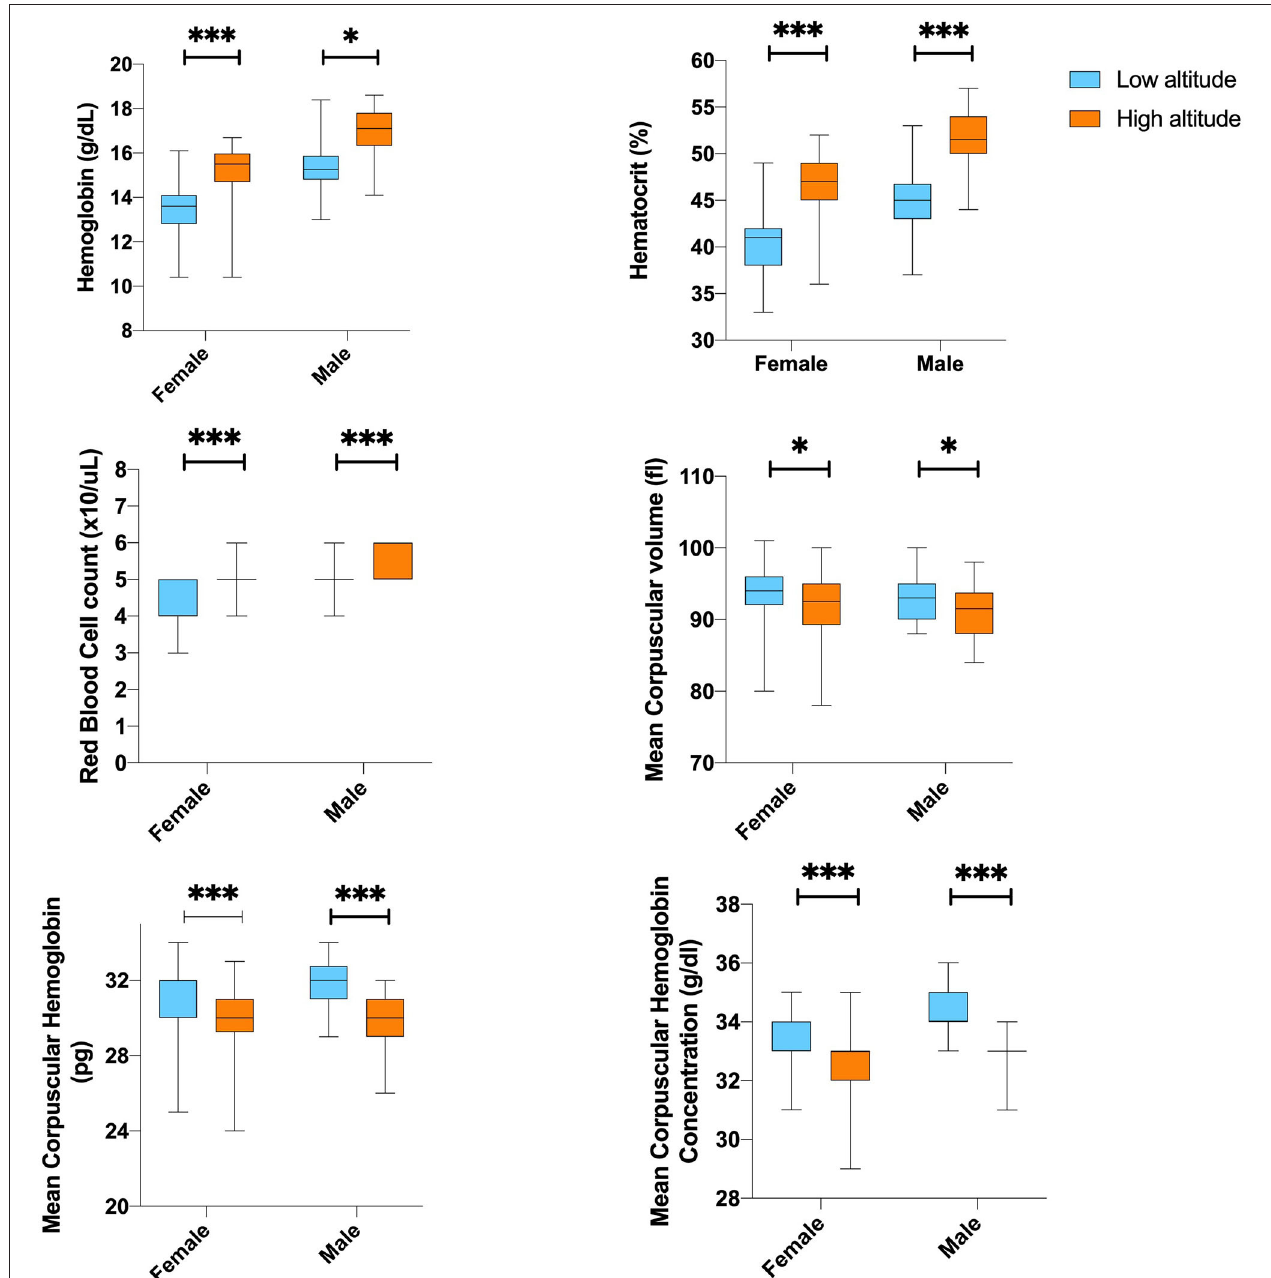
FIGURE 3 | Blood biochemistry and lipid profile difference value according to sex by altitude. ** , ***Represents outliers values.